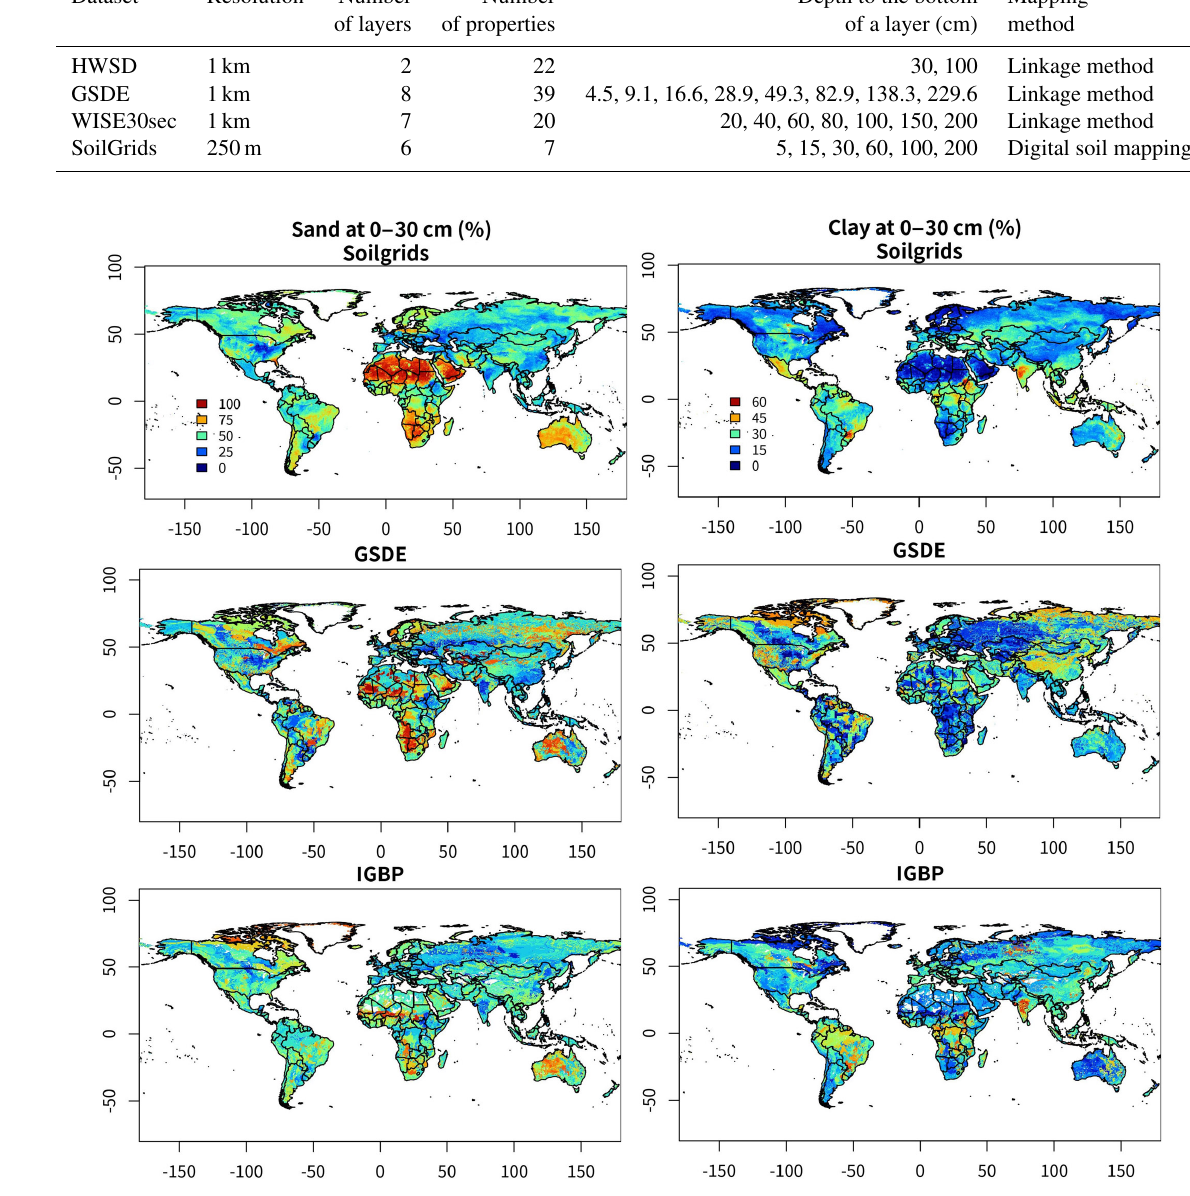
Figure 1. Soil sand and clay fraction at the surface 0–30cm layer from SoilGrids, IGBP, and GSDE. The difference among them will lead to different modelling results for ESMs. IGBP is the Data and Information System of the International Geosphere-Biosphere Program and GSDE is the Global Soil Dataset for Earth System